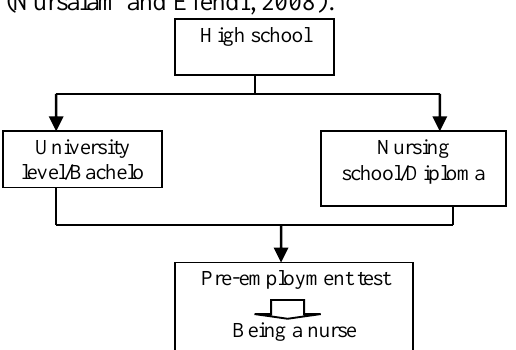
Figure 1. Indonesian nursing educational